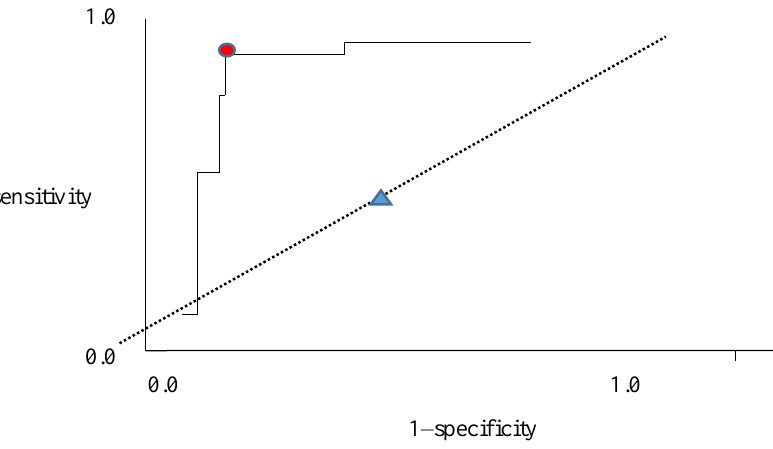
Figure 2. ROC plot with sensitivity to 1-specificity .